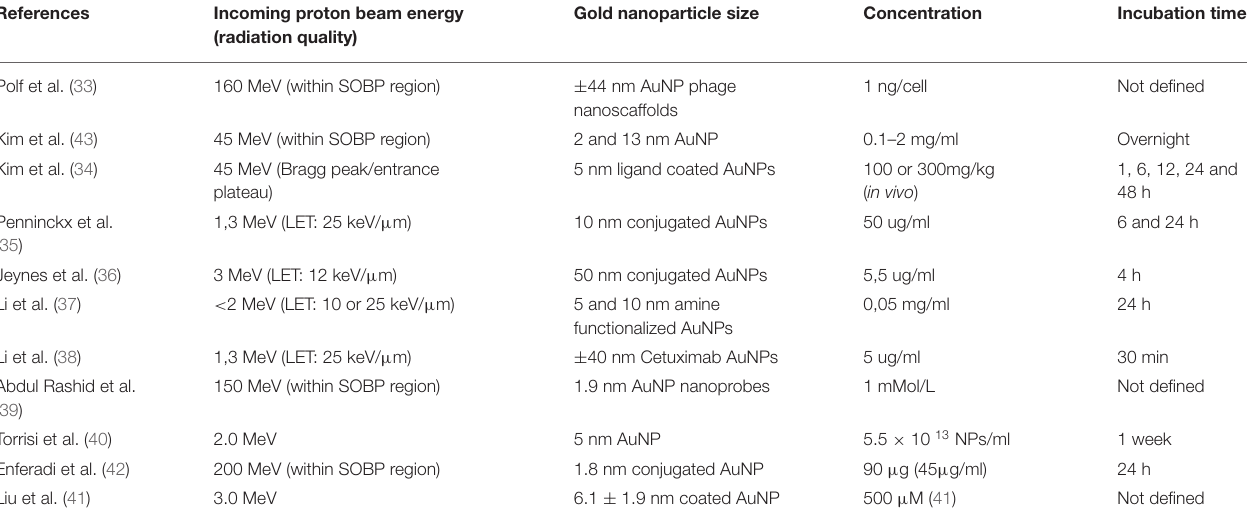
TABLE 1 | Overview of the existing radiobiological studies which investigated the potential radiosensitization effects of AuNPs in combination with proton